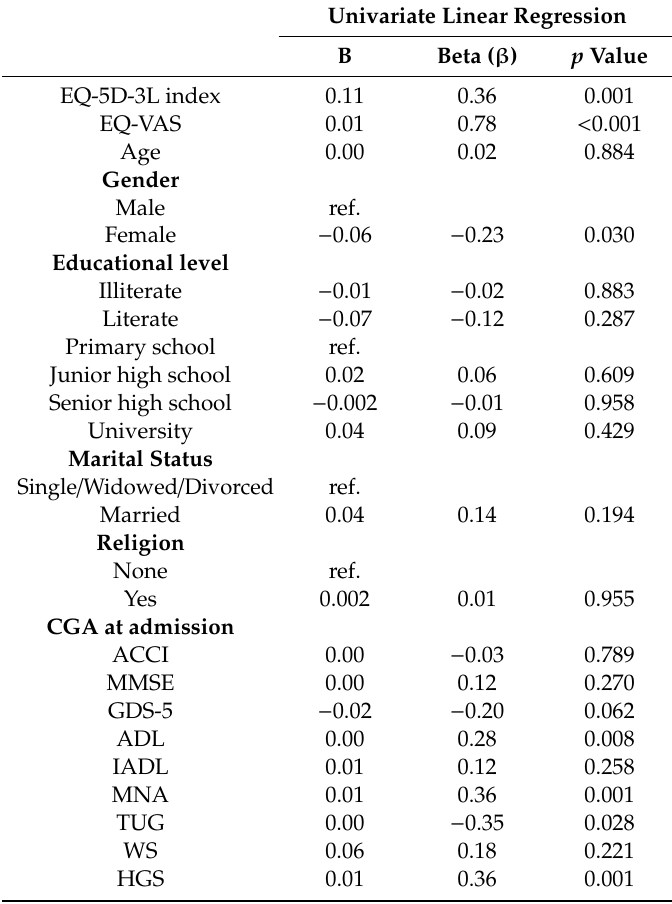
Table 4. Discharge EQ-VAS (Log 10 ) with comprehensive geriatric assessment parameters at admission.